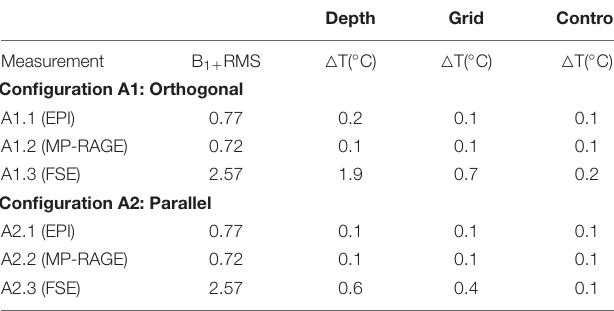
TABLE 3 | Results of Experiment A.